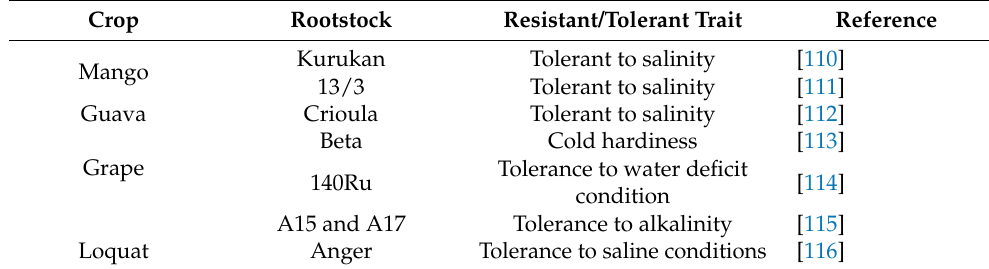
Table 5. List of abiotic resistant/ tolerant rootstocks in fruit crops. Crop Rootstock Resistant/Tolerant Trait Reference Kurukan Tolerant to salinity [110] Mango 13/3 Tolerant to salinity Guava Crioula Tolerant to salinity Grape